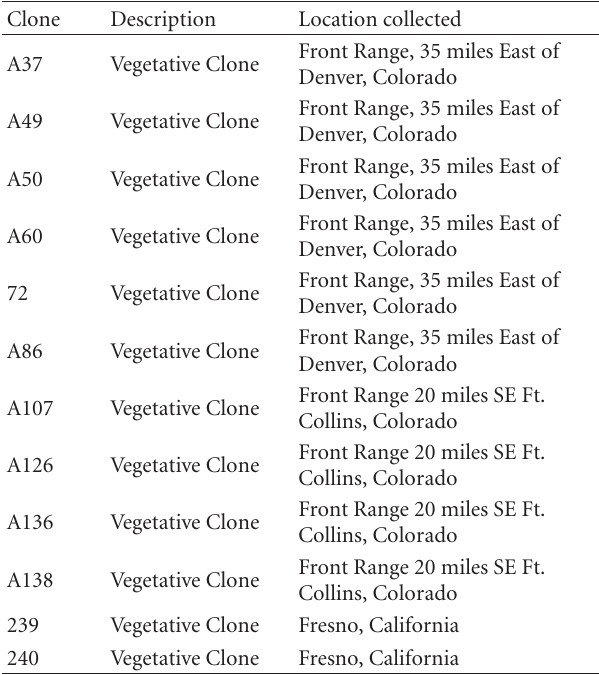
Table 1: Various saltgrass clones and their locations, where they have been